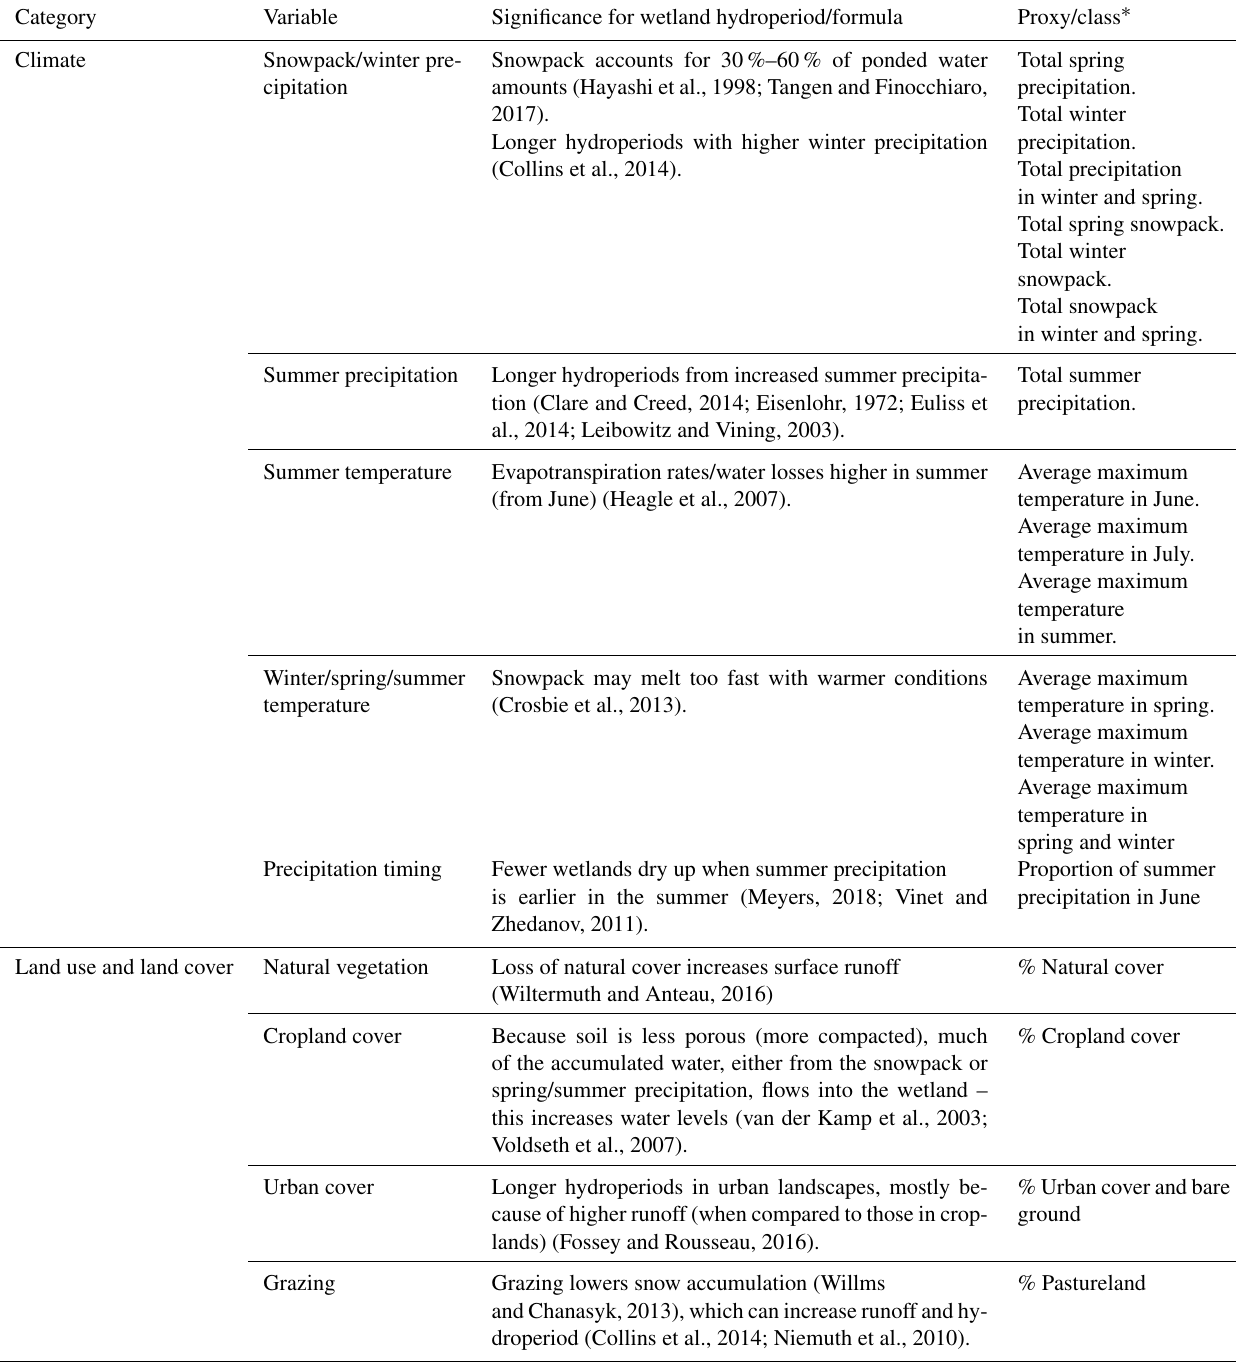
Table 2. List of annual data on climate, land cover and land use, and terrain metrics used to predict wetland permanence class. In this table, we include a description of the significance of each metric for the wetland hydroperiod and the proxy metrics we selected. For our analysis, winter months range from November to February, spring from April to May, and summer from June to August. We used Web of Science to conduct this review, limiting the search to papers published between 1950 and 2018, as well as key words for (1) the PPR – Prairie Pothole Region, Northern Great Plains, Alberta, Saskatchewan, Manitoba and Dakota; (2) weather – climate, temperature and precipitation; (3) disturbance – land use, agriculture, disturbance, oil and gas, grazing, and roads; and (4) pond permanence – watershed, hydroperiod, permanence class, catchment and wetland. We used “OR” operators between key words under the same class and “AND” operators between each key word class. For the terrain metrics, we used selected metrics that are commonly used to describe topographic variations, based on a previous review (Branton and Robinson, 2019). Notably, Branton and Robinson (2019) employed controls on collinearity, including principal component analysis